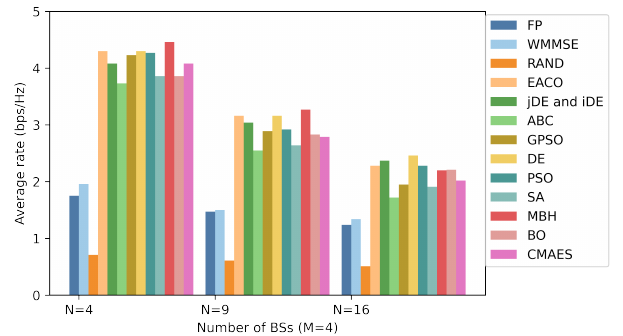
Figure 7. The average rate versus number of